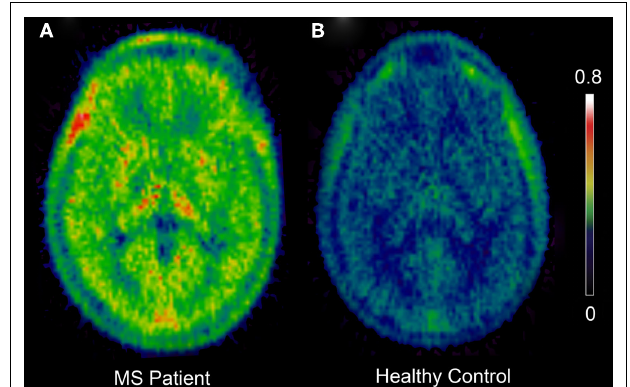
FIGURE 1 | Positron emission tomography images showing increased 11 C-PK11195 BP ND in a Multiple Sclerosis patient (A) when compared to a healthy normal control (B). Color bar represents intensity of 11 C-PK11195 tracer binding (BP ND ). BP ND , binding potential; MS, multiple